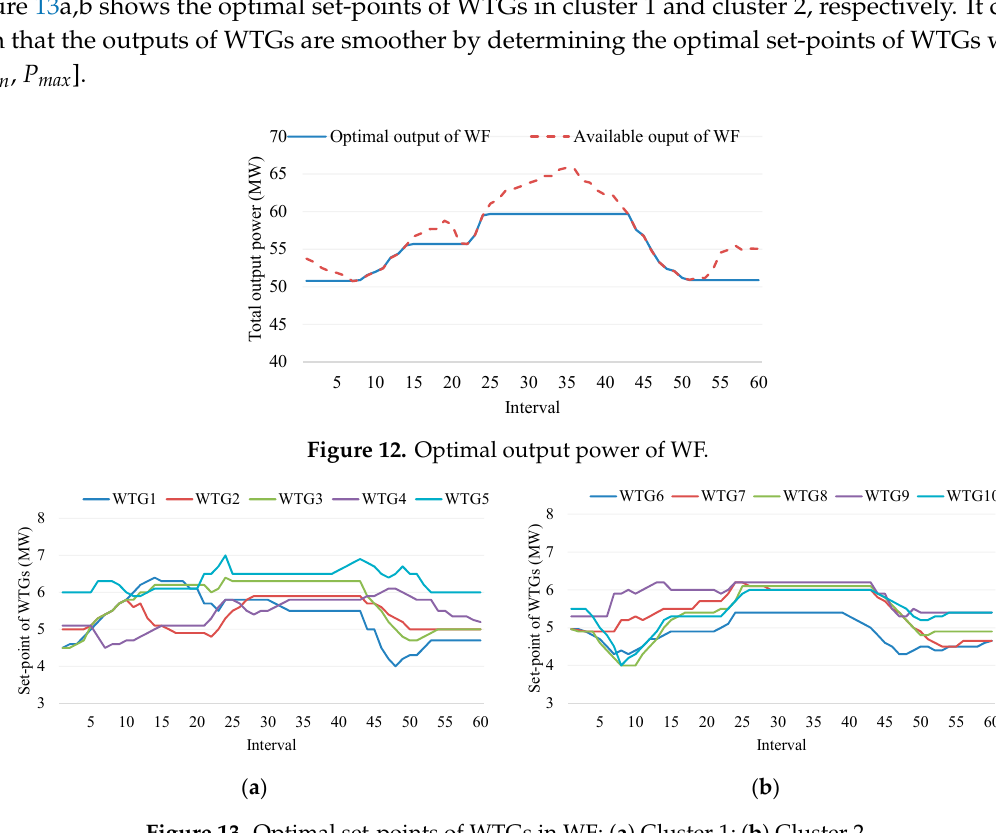
Figure 13. Optimal set-points of WTGs in WF: ( a ) Cluster 1; ( b ) Cluster 2.